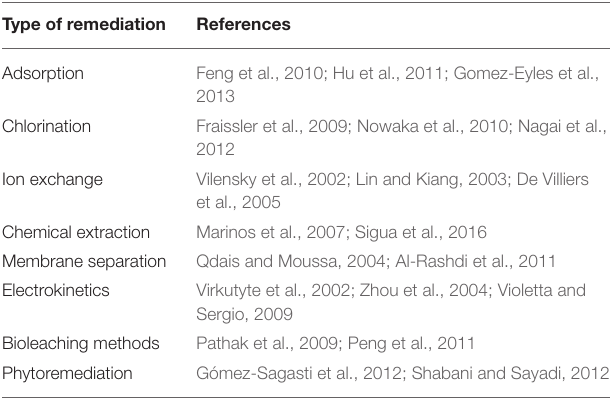
TABLE 3 | Existing methods of heavy metal